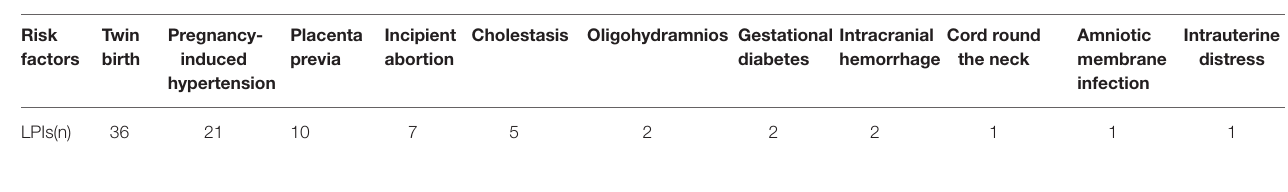
TABLE 2 | Perinatal risk factors in